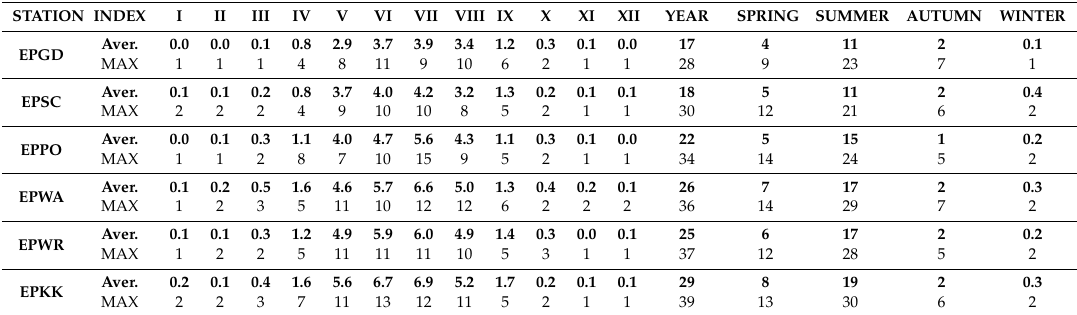
Table 1. This is. Average (Aver.) and maximum (MAX) number of days with a storm in Poland